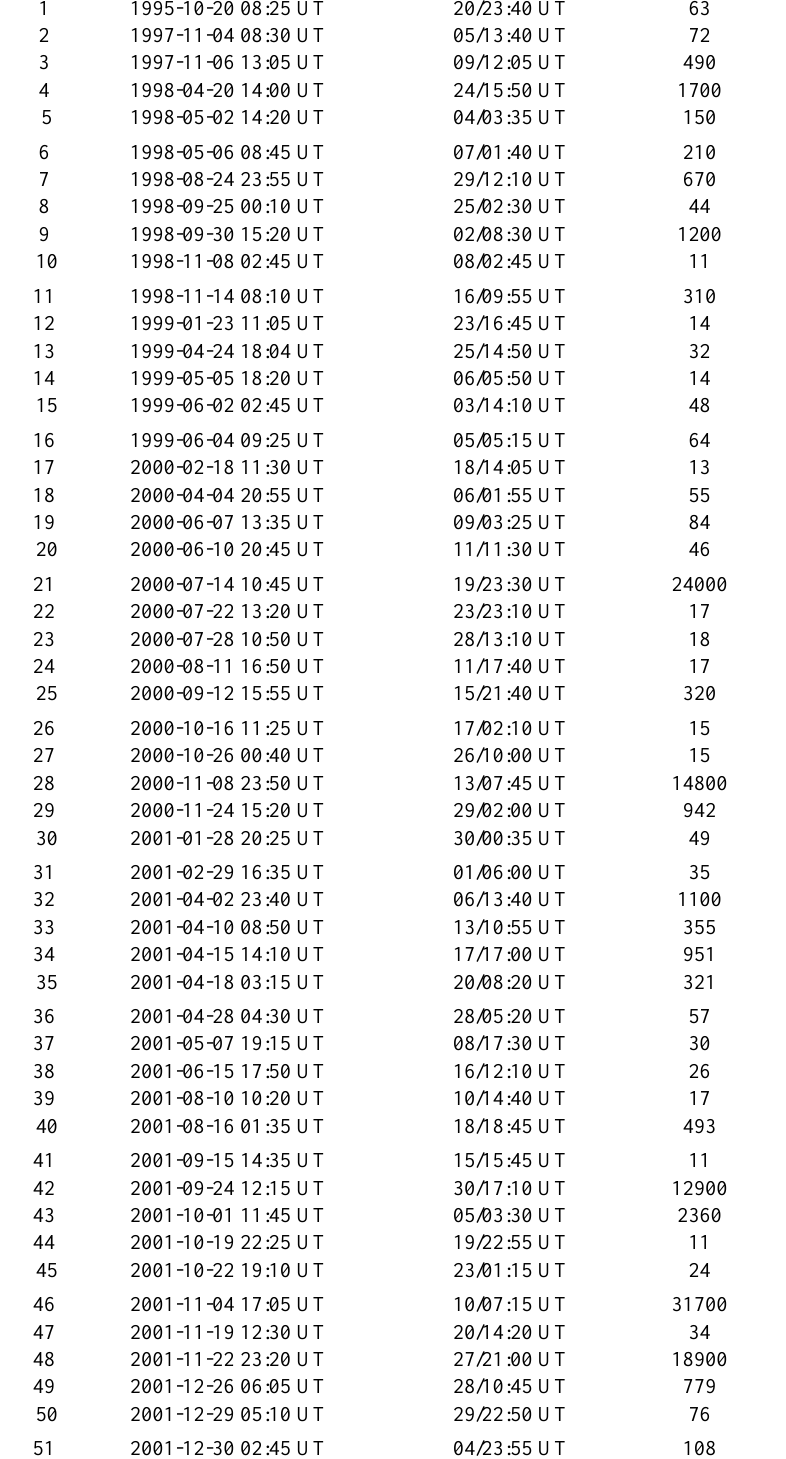
Table 2. All Solar Proton Events that contributed data to this study identified by number occurred since 1995 (first column). The second column lists the day and time when the integral proton flux (threshold of 10MeV) rises above 10 p.f.u.. In the third column the end time and date of the event are indicated. The final column lists the maximum proton flux during the